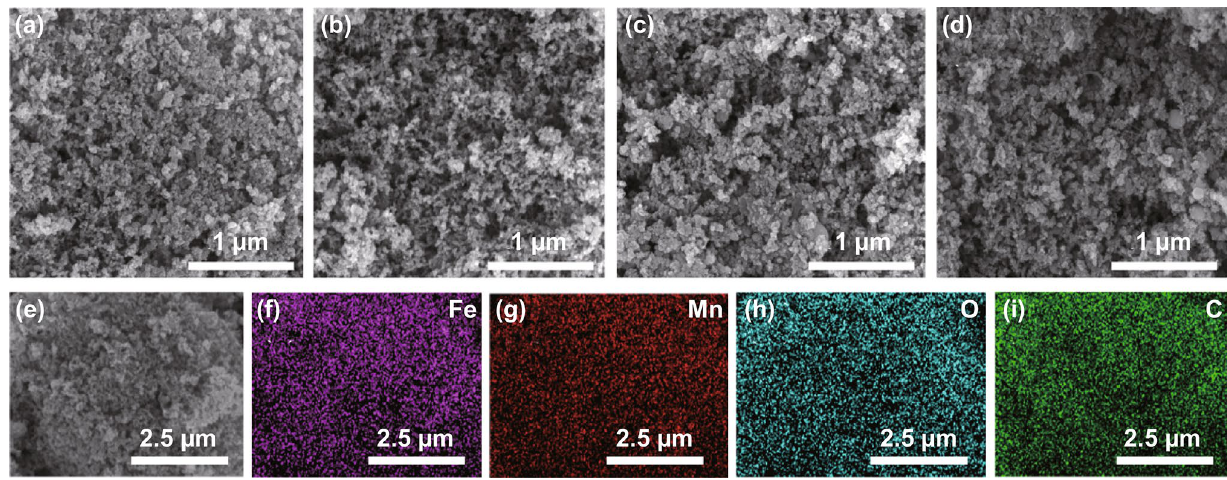
Fig. 1 SEM images of different samples: a FMCA-1, b FMCA-2, c FMCA-3, and d FMCA-4. e – i Elemental mapping images of